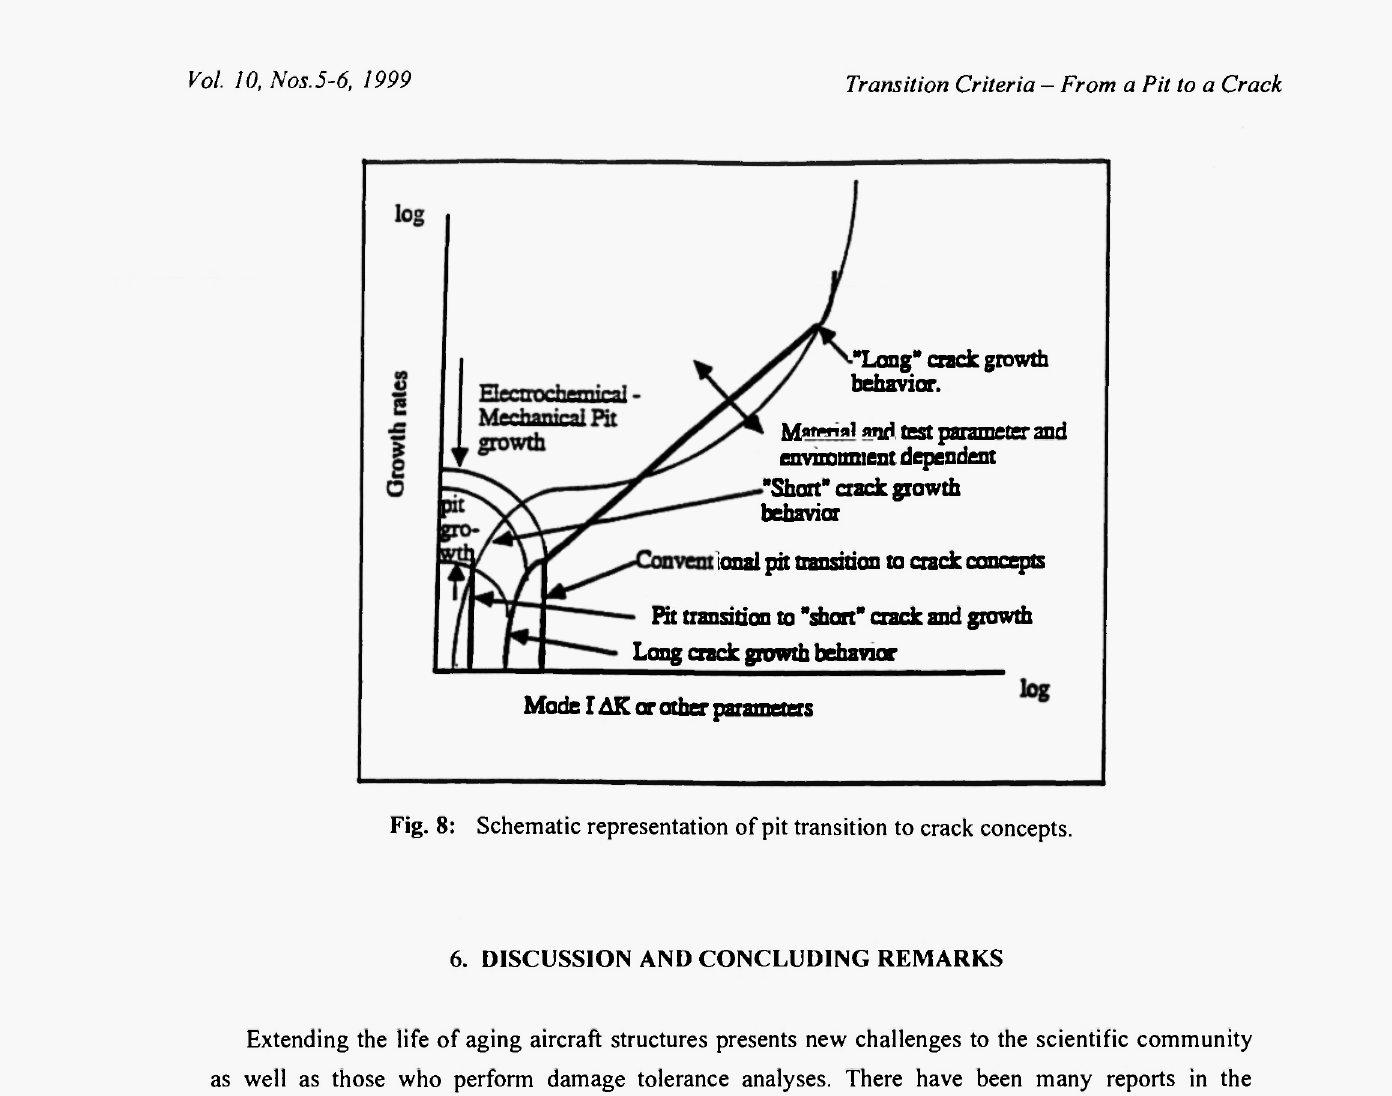
Fig. 8: Schematic representation of pit transition to crack